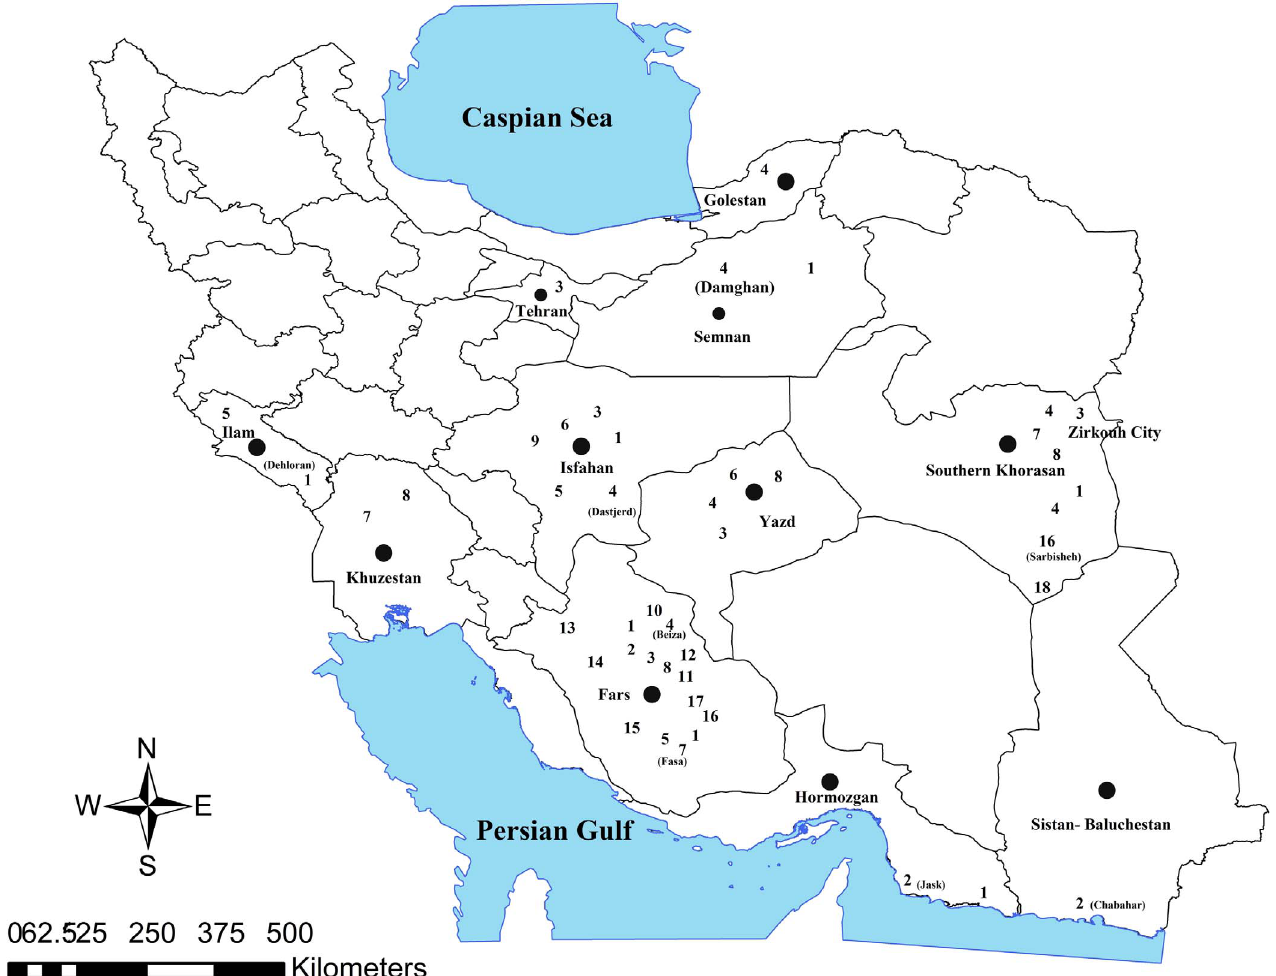
Fig. 4. Distribution of zoonotic cutaneous leishmaniasis in vectors in Iran; 1 : Phlebotomus papatasi , 2 : Phlebotomus Salehi , 3 : Phlebotomus sergenti , 4 : Phlebotomus caucasicus , 5 : Phlebotomus mongolensis , 6 : Phlebotomus ansarii , 7 : Phlebotomus alexandri , 8 : Sergentomyia dentata , 9 : Phlebotomus anderjevi , 10 : Phlebotomus tobbi , 11 : Sergentomyia theodori , 12 : Sergentomyia clydei , 13 : Sergentomyia Baghdadis , 14 : Sergentomyia squamipleuris , 15 : Phlebotomus bergeroti , 16 : Sergentomyia sintoni , 17 : Sergentomyia tiberiadis , 18 : Phlebotomus jacusieli